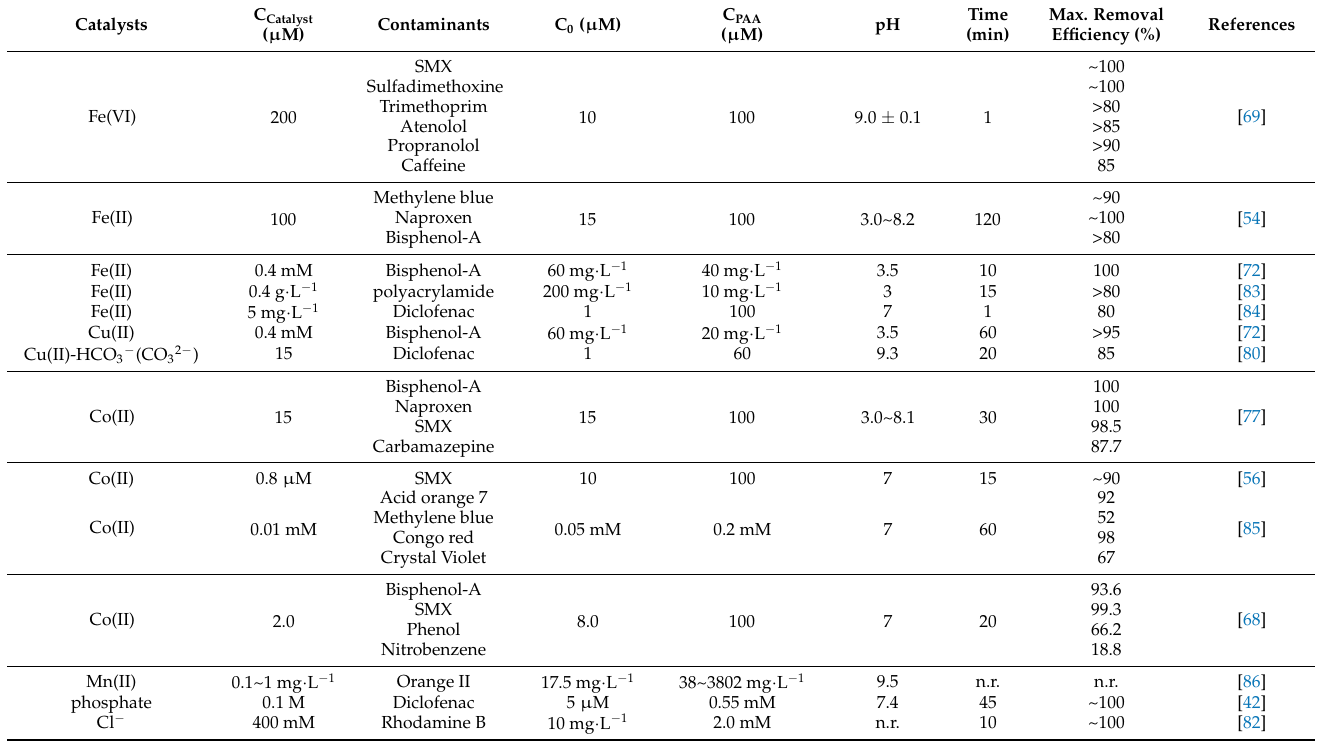
Table 3. Studies of activating PAA in homogeneous phase